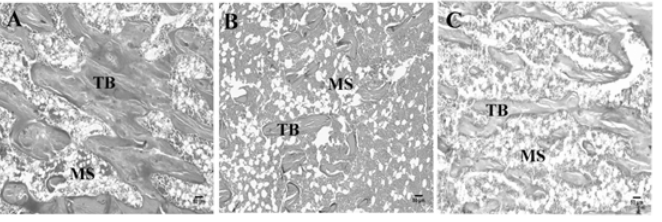
Fig 1. Histological analyses of the right tibias. Hematoxylin and eosin staining of longitudinal sections of tibias of the control (A), type 1 diabetes mellitus (T1DM) (B), and T1DM plus zinc supplementation (T1DMS) (C) groups. TB, trabecular bone; MS, medullary space; magnification 20X, scale bar: 50 μ